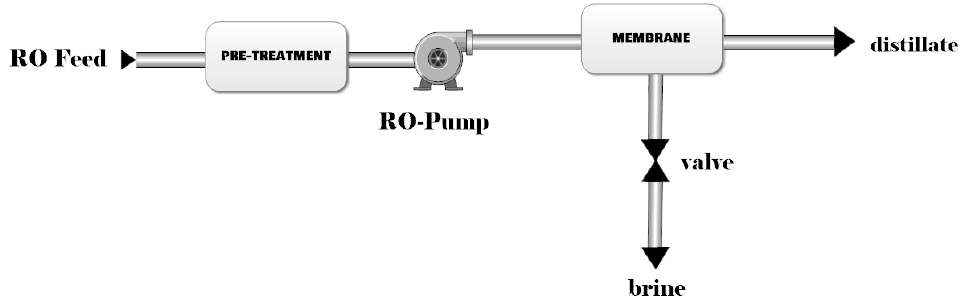
Figure 4. Schematic diagram of the reverse osmosis (RO) desalination unit.